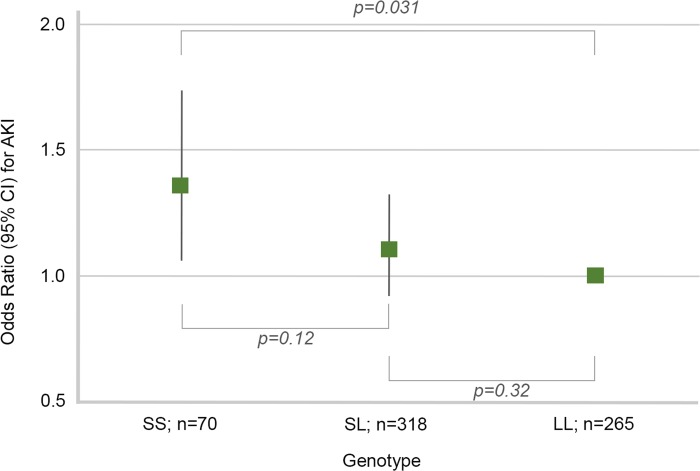
Odds ratio (OR) of acute kidney injury (AKI) according to genotype (SS, SL, or LL).